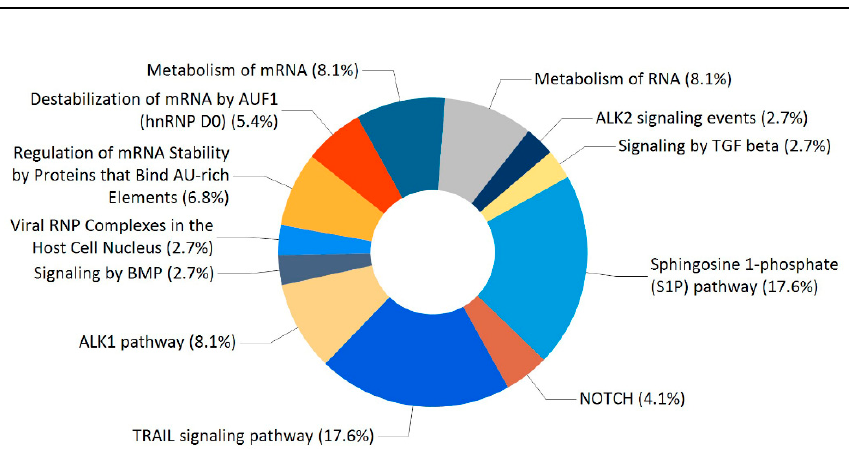
Figure 5. Classifications of biological pathways for the 74 proteins.